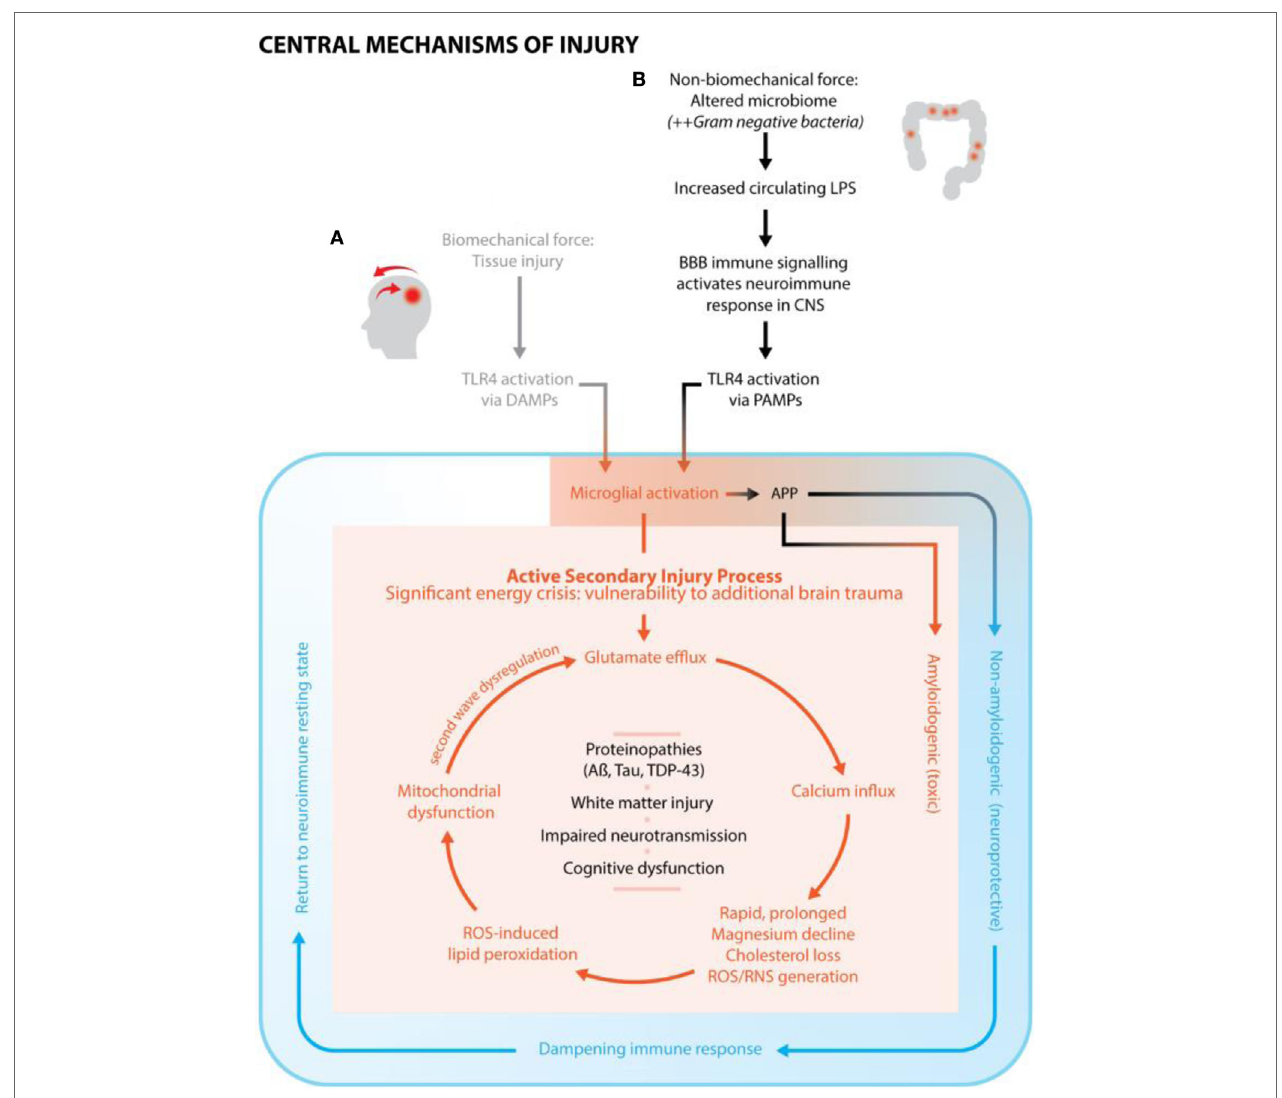
FiGURe 1 | A conceptualized framework of brain injury, cross-linking subfields of neuroscience, nutrition, and environmental toxicology. (A) Biomechanical force causes tissue damage (primary injury) and initiates neuroimmune response. Secondary injury, with a characteristic cascade of neurochemical events, occurs from the point of primary injury and continues for days, weeks, or months. Over the course of injury, the neuroimmune response goes from fully activated, to an immune dampening state, to finally a return to resting state. (B) Altered microbiome/increased circulating lipopolysaccharide (LPS) is hypothesized to be the primary injury, which activates the neuroimmune response, including the classic secondary injury features and neurochemical events as seen with conventional brain trauma. It is conjectured that this type of injury is most associated with chronic, subclinical neuroimmune